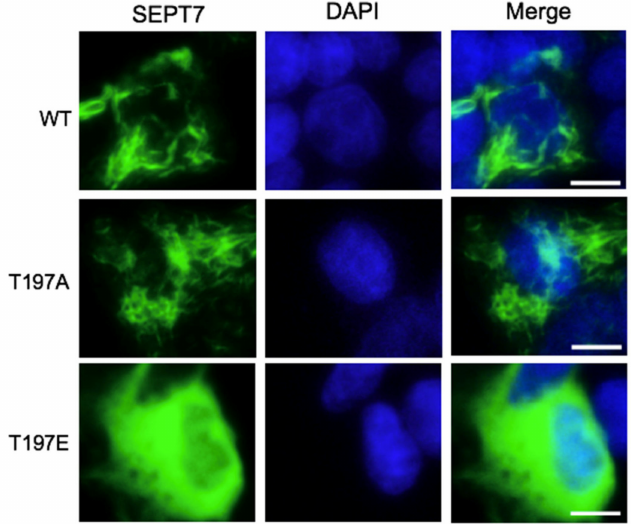
Figure 4. SEPT7 phosphorylation disrupts septin filament formation. The plasmids of GFP-SEPT7, GFP-SEPT7 T197A (de-phosphorylated status), and GFP-SEPT7 T197E (constitutive phosphorylated status) were transfected into 293T cells. Septin filaments were observed in cells transfected with wild-type (WT) SEPT7 (upper panel) and T197A (middle panel), but not in T197E (lower panel) constructs. DNA was stained with DAPI (blue). Scale bar: 10 µ m (white